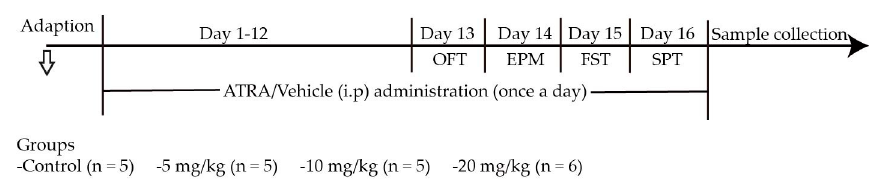
Figure 6. Experimental schedules for administration of ATRA and testing for anxiety- and depression-like behavior to explore the effect of ATRA on changes in behavior and synaptic gene expression in mice. OFT: open-field test; EPM: elevated-plus maze; FST: forced swimming test; SPT: sucrose preference test.